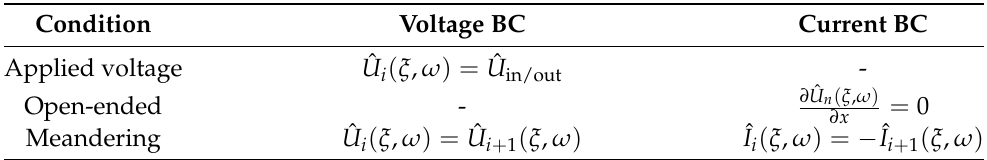
Table 1. A summary of the different boundary conditions, where, for the outer x -positions, we have ξ = 0 ∨ L